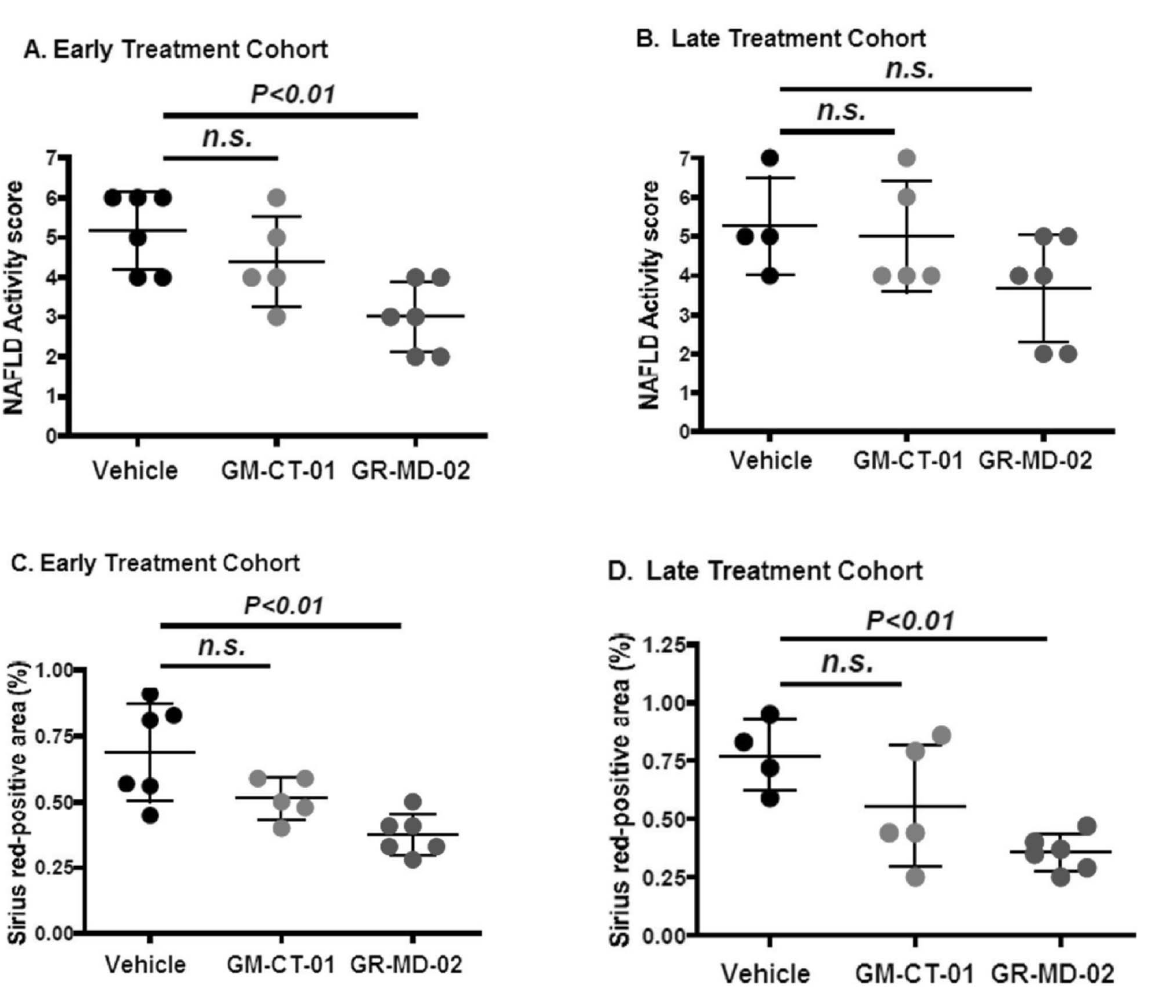
Figure 2. Quantification of NAFLD Activity Score (NAS) and collagen area. Figure 2A and 2B show NAFLD Activity Score for groups administered twice weekly intravenous injections of vehicle (0.9% NaCl), GM-CT-01 (120 mg/kg), or GR-MD-02 (60 mg/kg) for the early and late treatment cohorts, respectively. Figure 2C and 2D show percent Sirius red positive area for groups administered twice weekly intravenous injections of vehicle (0.9% NaCl), GM-CT-01 (120 mg/kg), or GR-MD-02 (60 mg/kg) for the early and late treatment cohorts, respectively. Differences between the vehicle group and the treatment groups were assessed by one way ANOVA followed by Bonferroni Multiple Comparison Test. P values , 0.05 were considered significant and results expressed as mean 6 SD.